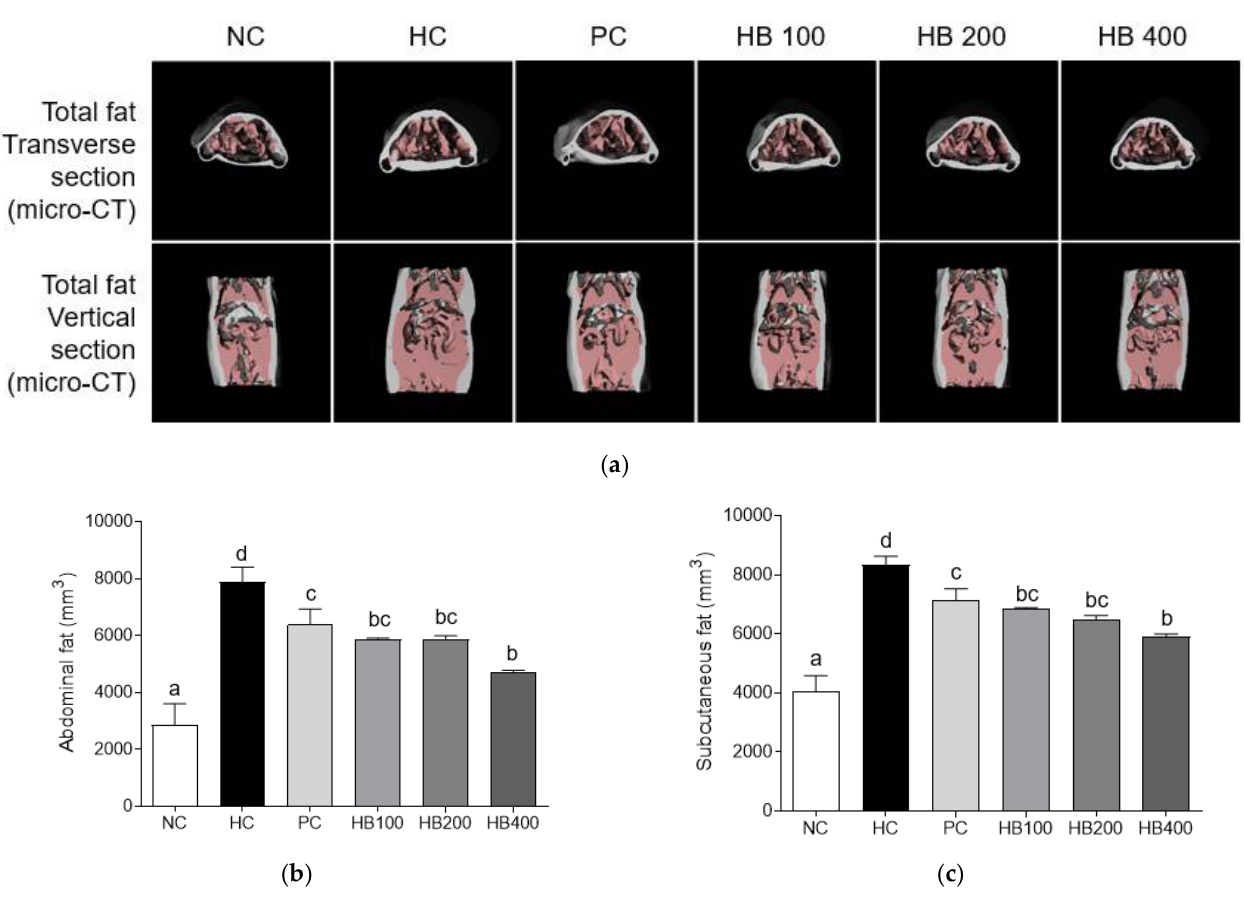
Figure 4. Effects of HB extract on fat mass. ( a ) Micro-CT analysis of total fat transverse section and total fat vertical section; ( b ) abdominal fat volumes; and ( c ) subcutaneous fat volumes. NC, Normal diet Control; HC, HF diet control; PC, HF diet with orlistat at 20 mg/kg; HB100, HF diet with honeysuckle berry extract at 100 mg/kg; HB200, HF diet with honeysuckle berry extract at 200 mg/kg; HB400, HF diet with honeysuckle berry extract at 400 mg/kg; Micro CT, micro-computed tomography. Data are presented as mean ± SD ( n = 8). Different letters indicate significant differences by one-way ANOVA ( p < 0.05) followed by Duncan’s multiple range tests.